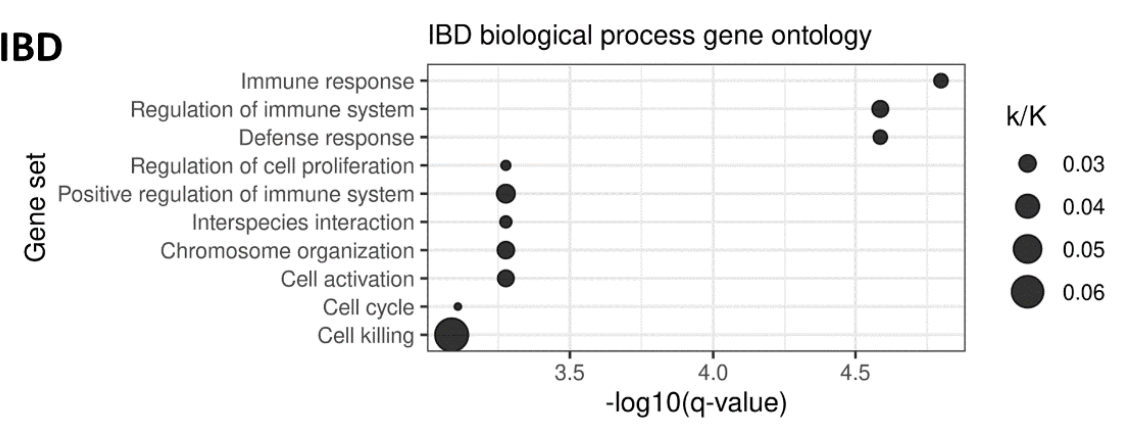
Figure 1. Gene ontology analysis of the genes included in the lasso models for the prediction of IBD, UC, and CD status. The ratio of the number of genes in overlap (k) to all genes in the given gene set (K) is indicated. 4. Discussion We applied an ML algorithm to IBD transcriptomic data and obtained a list of genes that may be involved in the pathogenesis of IBD. At study conception, the source expres- sion data from Ostrowski et al. presented the richest whole-blood IBD transcriptome and had not been explored using ML methods. The results from lasso regression implicate inflammation, the TGF-beta pathway, immunoglobulins, NK cells, and other mechanisms in the pathogenesis of IBD. Interestingly, most of the genes identified by PCA and lasso were not among the top differentially expressed genes in the original study by Ostrowski et al. [10]. This can po- tentially be explained by less pronounced, more systematic differences. In children, indi- viduals that expressed the most differential transcripts in Ostrowski et al. had very high AUC values within the test set, even superior to those obtained by lasso. However, the diagnostic accuracy was found to be lower in an independent replication using qPCR. In adults, the highest AUC achieved by Ostrowski et al. in the validation cohort using a set of five genes was 0.78 (active UC). Our study, using a set of two genes, was capable of identifying active CD with an average AUC of 0.92 in 10-fold cross-validation. However, it is uncertain how this classifier would perform when translated to qPCR. These results